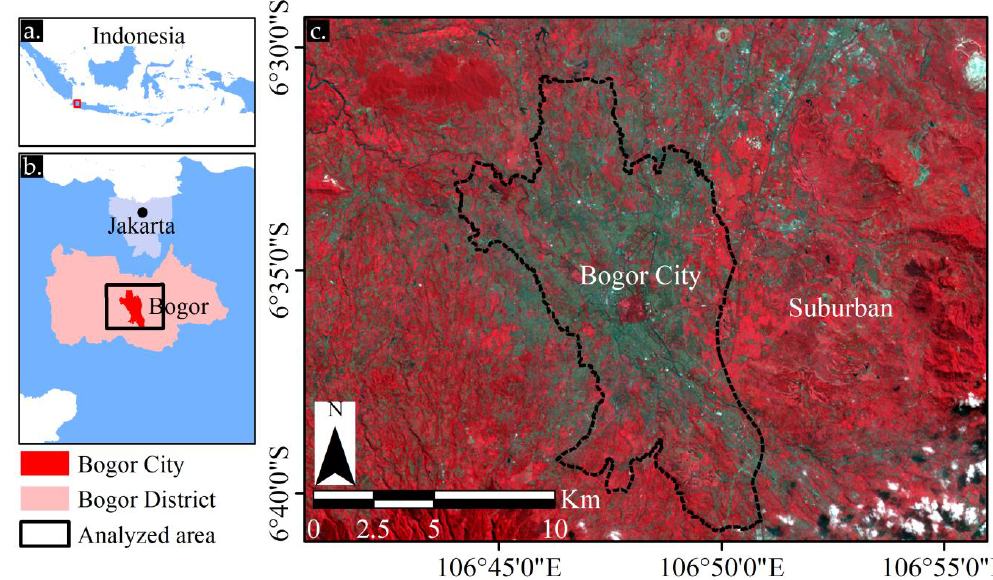
Figure 1. Map of analyzed area. ( a ) Location in Indonesia; ( b ) Bogor District and surrounding area, and ( c ) analyzed area in this study (Bogor City and suburban area).